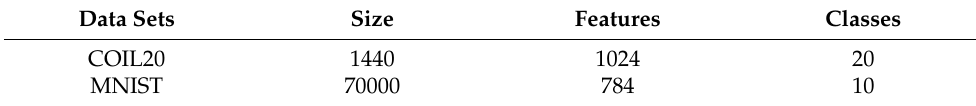
Table 1. Statistics of the datasets used in our